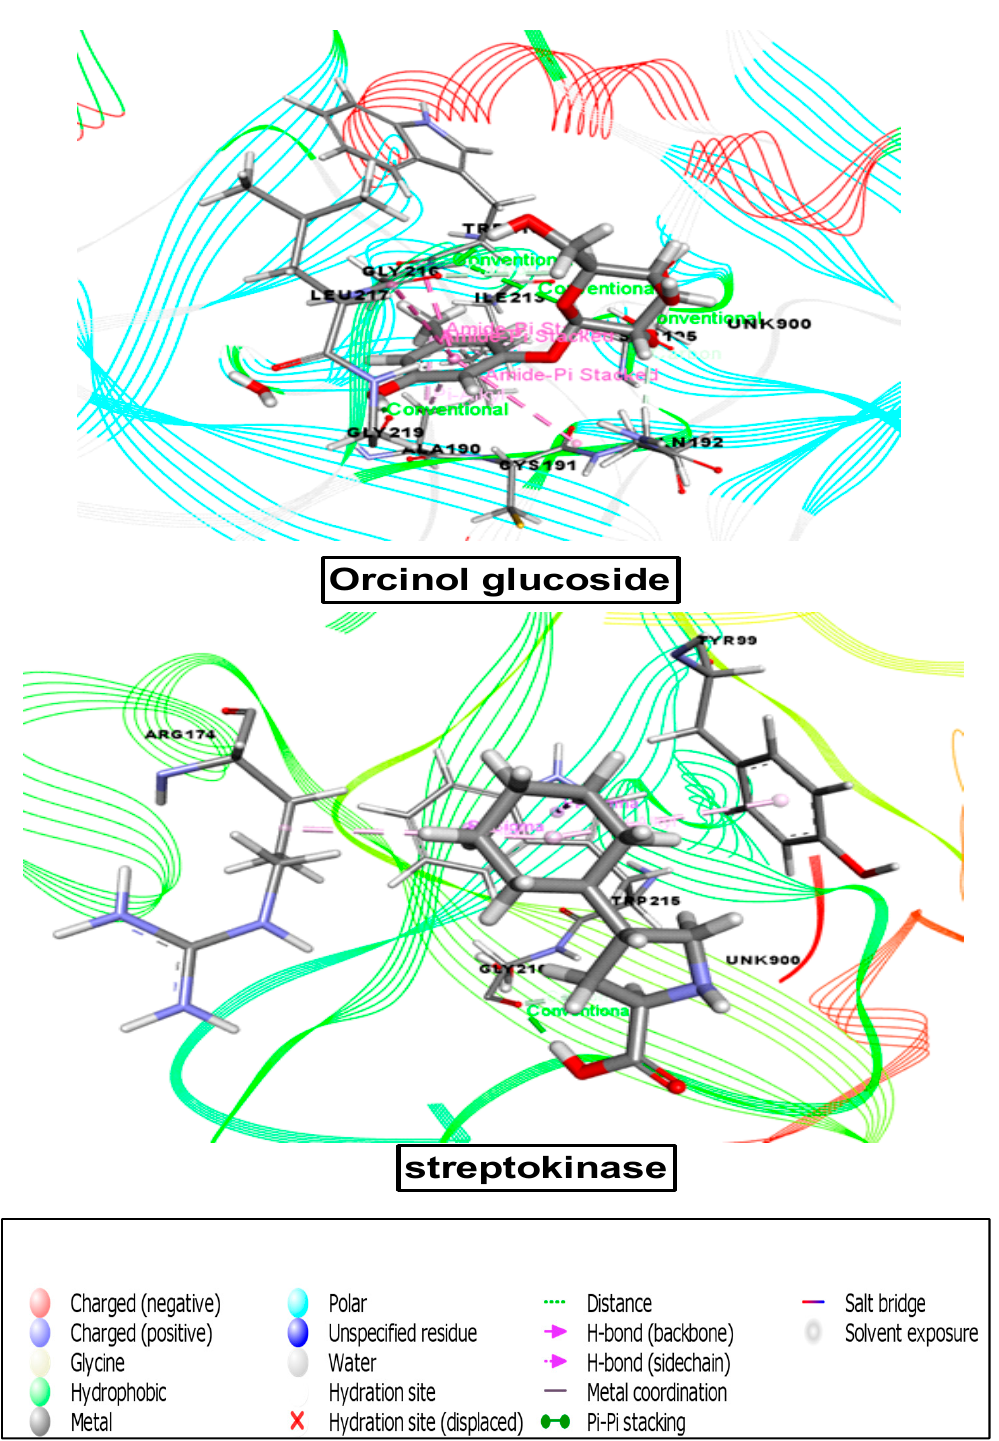
Figure 6. Best ranked pose of the major compounds of M. capitulata . Orcinol glucoside and standard drug (streptokinase) in the binding pocket of human tissue-type plasminogen activator (PDB ID: 1A5H) for thrombolytic activity.